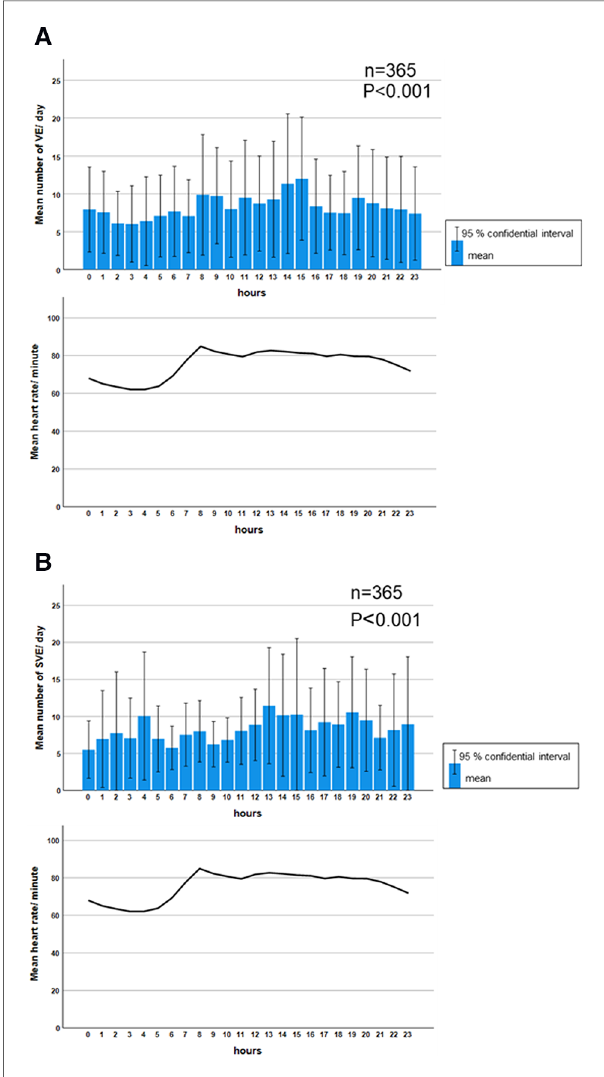
FIGURE 2 Diurnal variation in the median frequency of ventricular and supraventricular ectopy. A signi fi cant diurnal variation was observed in the mean frequency of VE ( P <0.001). The daytime prevalence of VE was predominant, which was parallel to the diurnal variation in HR ( A ). Meanwhile, the mean frequency of SVE was signi fi cantly higher at 4:00 and during 13:00 – 15:00 ( P <0.001). However, the diurnal variation of SVE was not parallel to the diurnal variation of HR ( B ). Comparisons of frequencies among each hour in VE and SVE were performed using the Kruskal – Wallis test. HR: heart rate, SVE: supraventricular ectopy, VE: ventricular ectopy.